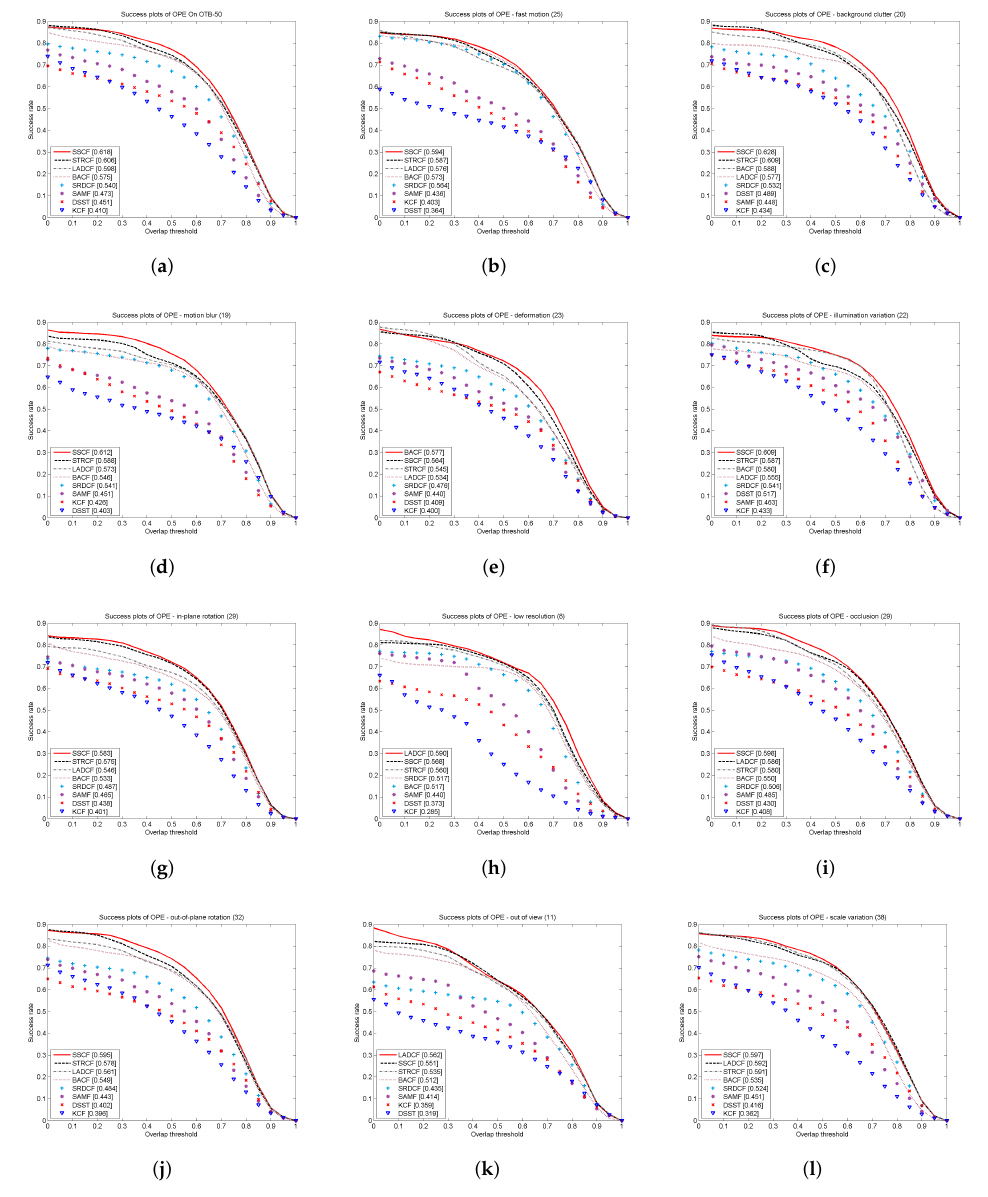
Figure 3. Success plots of the proposed SSCF and the other trackers on the OTB50 database. ( a ) Overall performance; ( b – l ) success plots on the 11 different